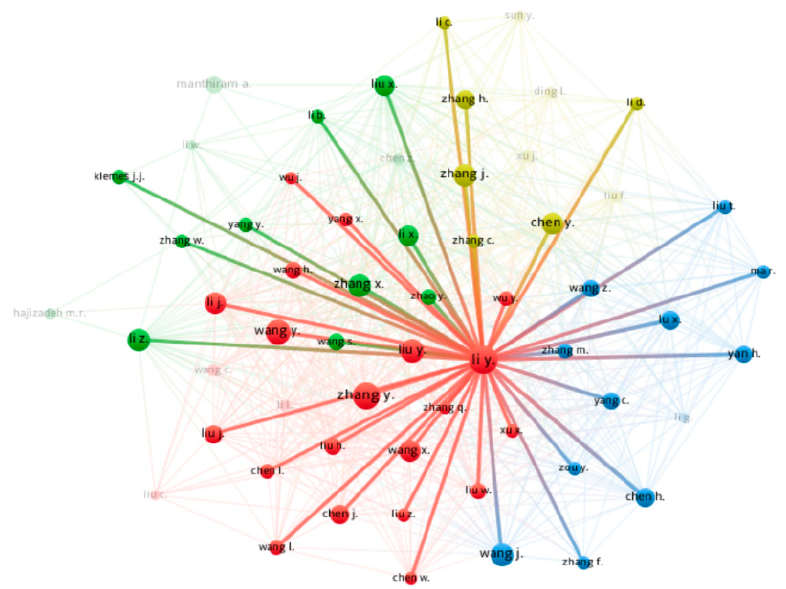
Figure 6. Network citation map of top 5 publications on renewable energy, sustainability and the environment, 2020–2021 (Based on the SciVal database (www.scival.com, accessed on 7 April 2021); data source: Scopus (downloaded on 7 April 2021); copyright: Elsevier B.V.).